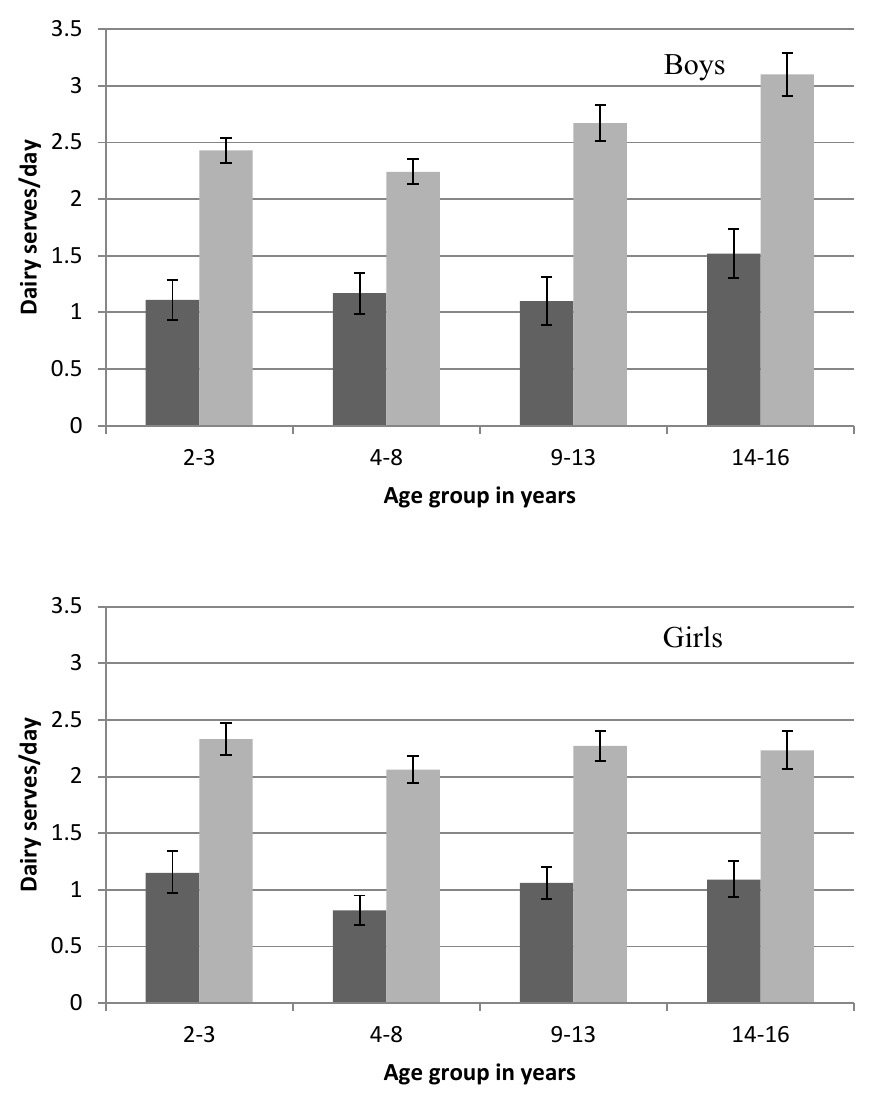
Figure 3. Mean daily serves of dairy food by sex, age group and whether dairy food was consumed at the first occasion ( full day intake for children where no dairy food was consumed at the first eating occasion, full day intake for children where dairy food was consumed at the first eating occasion) on the day surveyed from the 2007 Australian National Children’s Nutrition and Physical Activity Survey (Computer Assisted Personal Interview